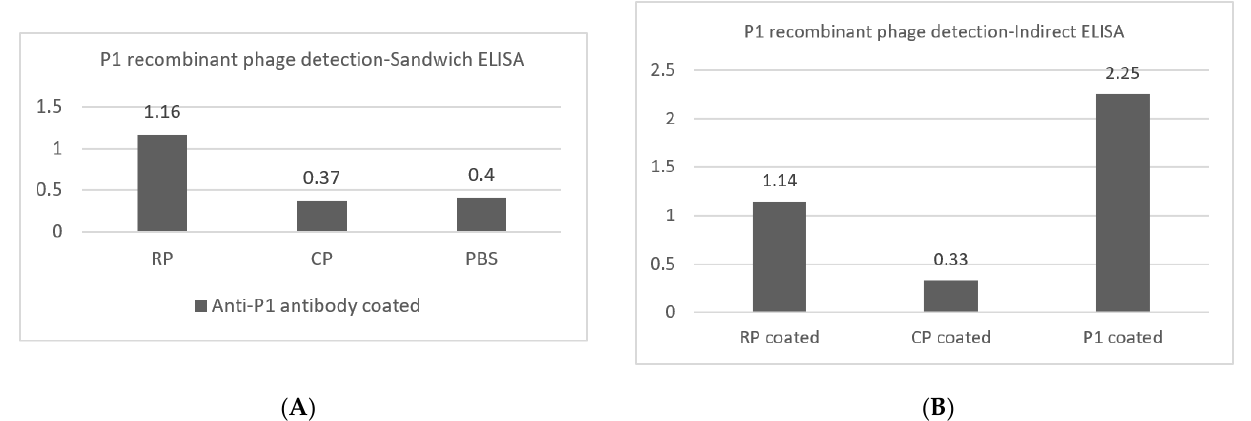
Figure 4. P1 display on recombinant M13 phage. ( A ): Sandwich ELISA: Coated anti-P1